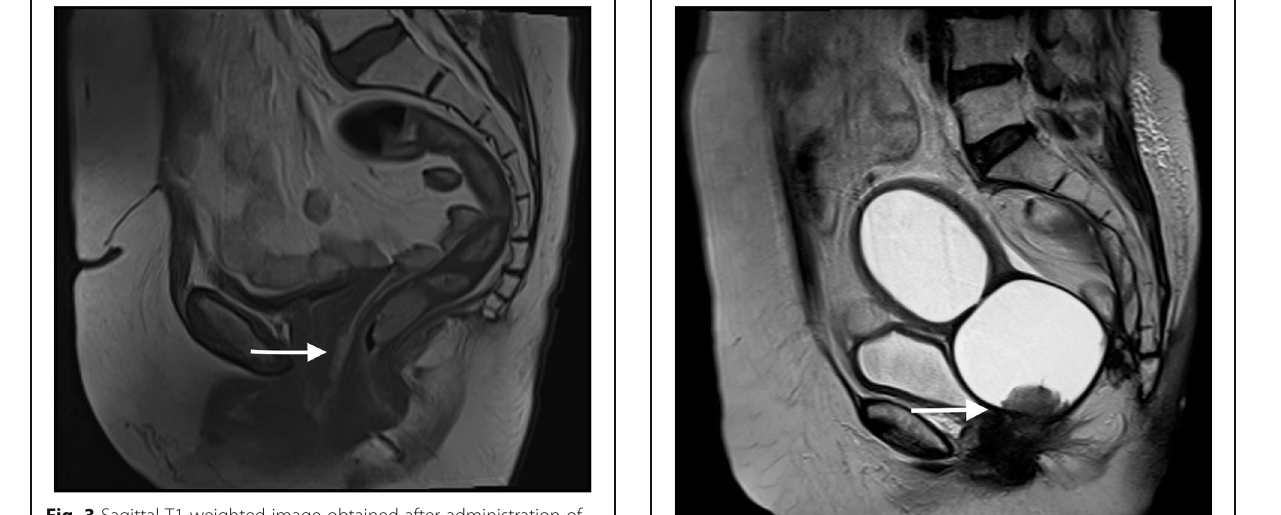
Fig. 3 Sagittal T1-weighted image obtained after administration of contrast material demonstrates longitudinal thickening and enhancement of vaginal walls distally (arrow)